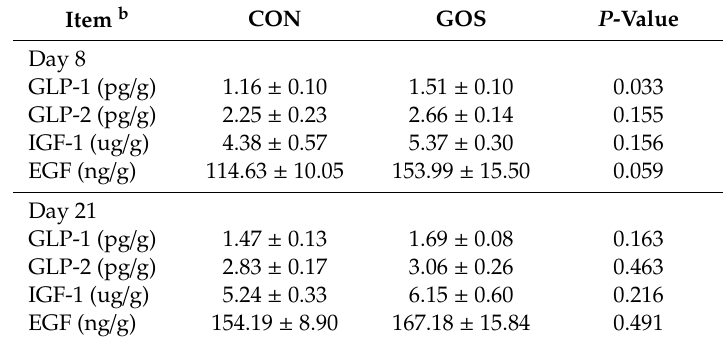
Table 2. The concentrations of endocrine peptides in ileal mucosa of piglets on the day 8 and day 21 a